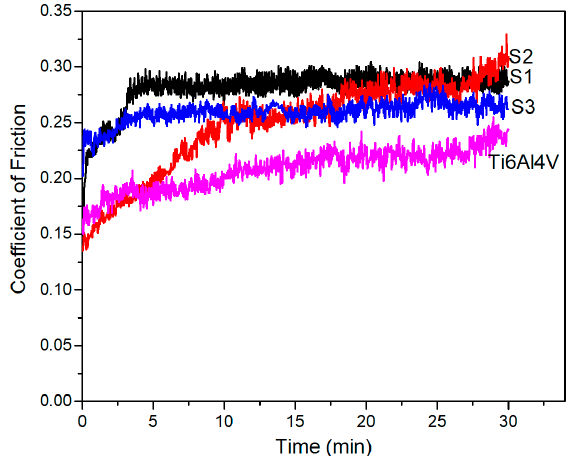
Figure 8. The variation of COF versus time of coated and uncoated Ti6Al4V